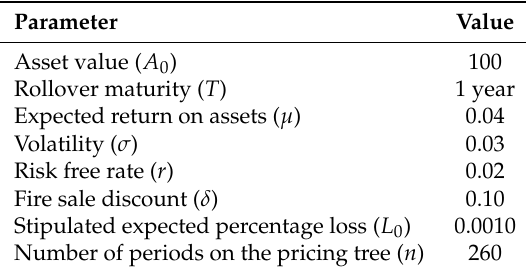
Table 1. Initial case